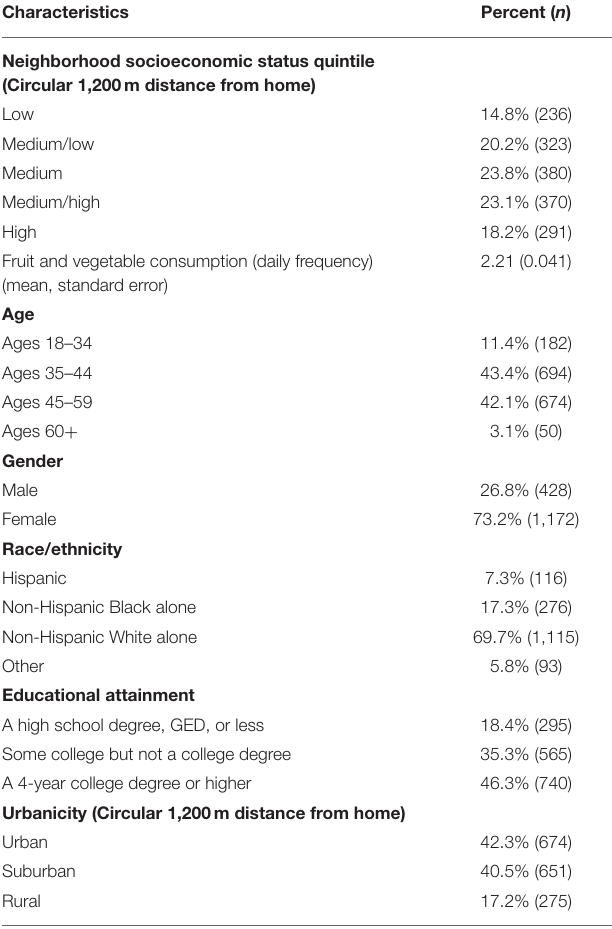
TABLE 1 | Unweighted sample characteristics ( n = 1,600) * included in analysis from the National Cancer Institute’s FLASHE Study.